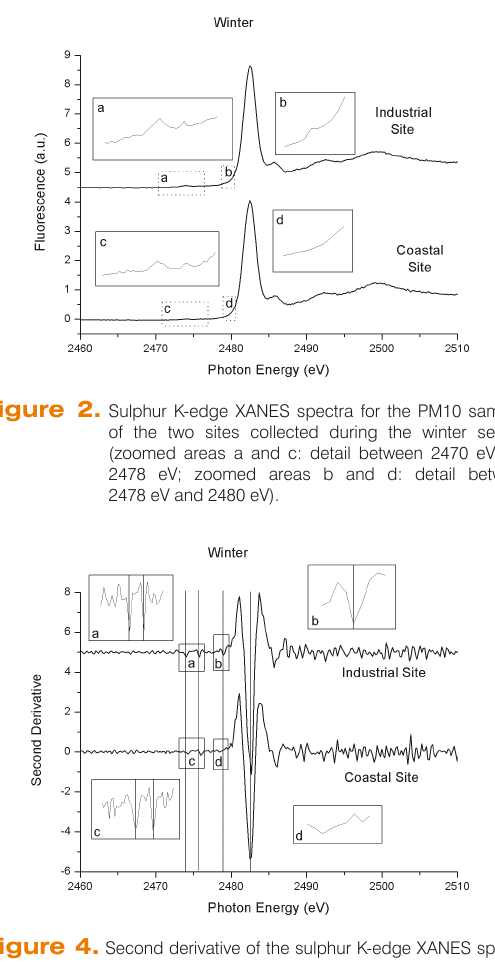
Figure 5. Second derivative of the sulphur K-edge XANES spectra for the PM10 samples in the two sites of the two sites col- lected during the summer season (zoomed areas a and c: detail between 2470 and 2478 eV; zoomed areas b and d: detail between 2478 and 2480